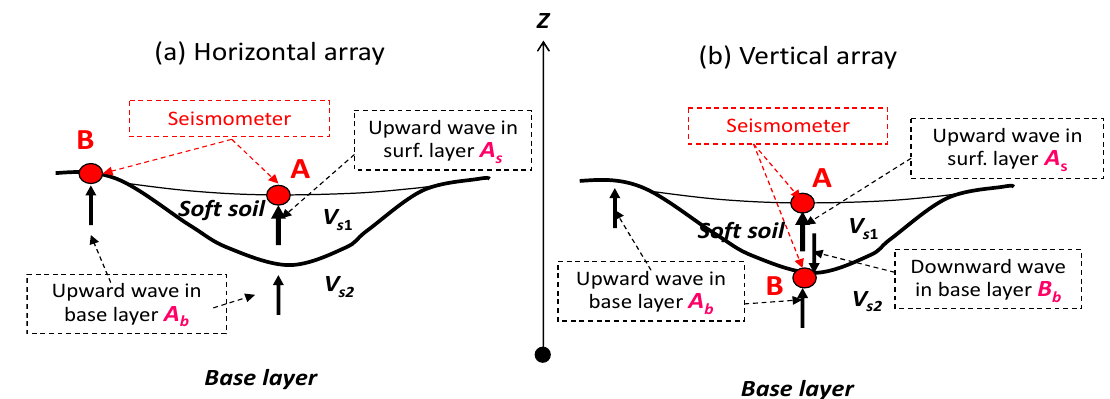
Figure 3. Schematical view of the horizontal array ( a ), and the vertical array in earthquake observation for site amplification ( b ).